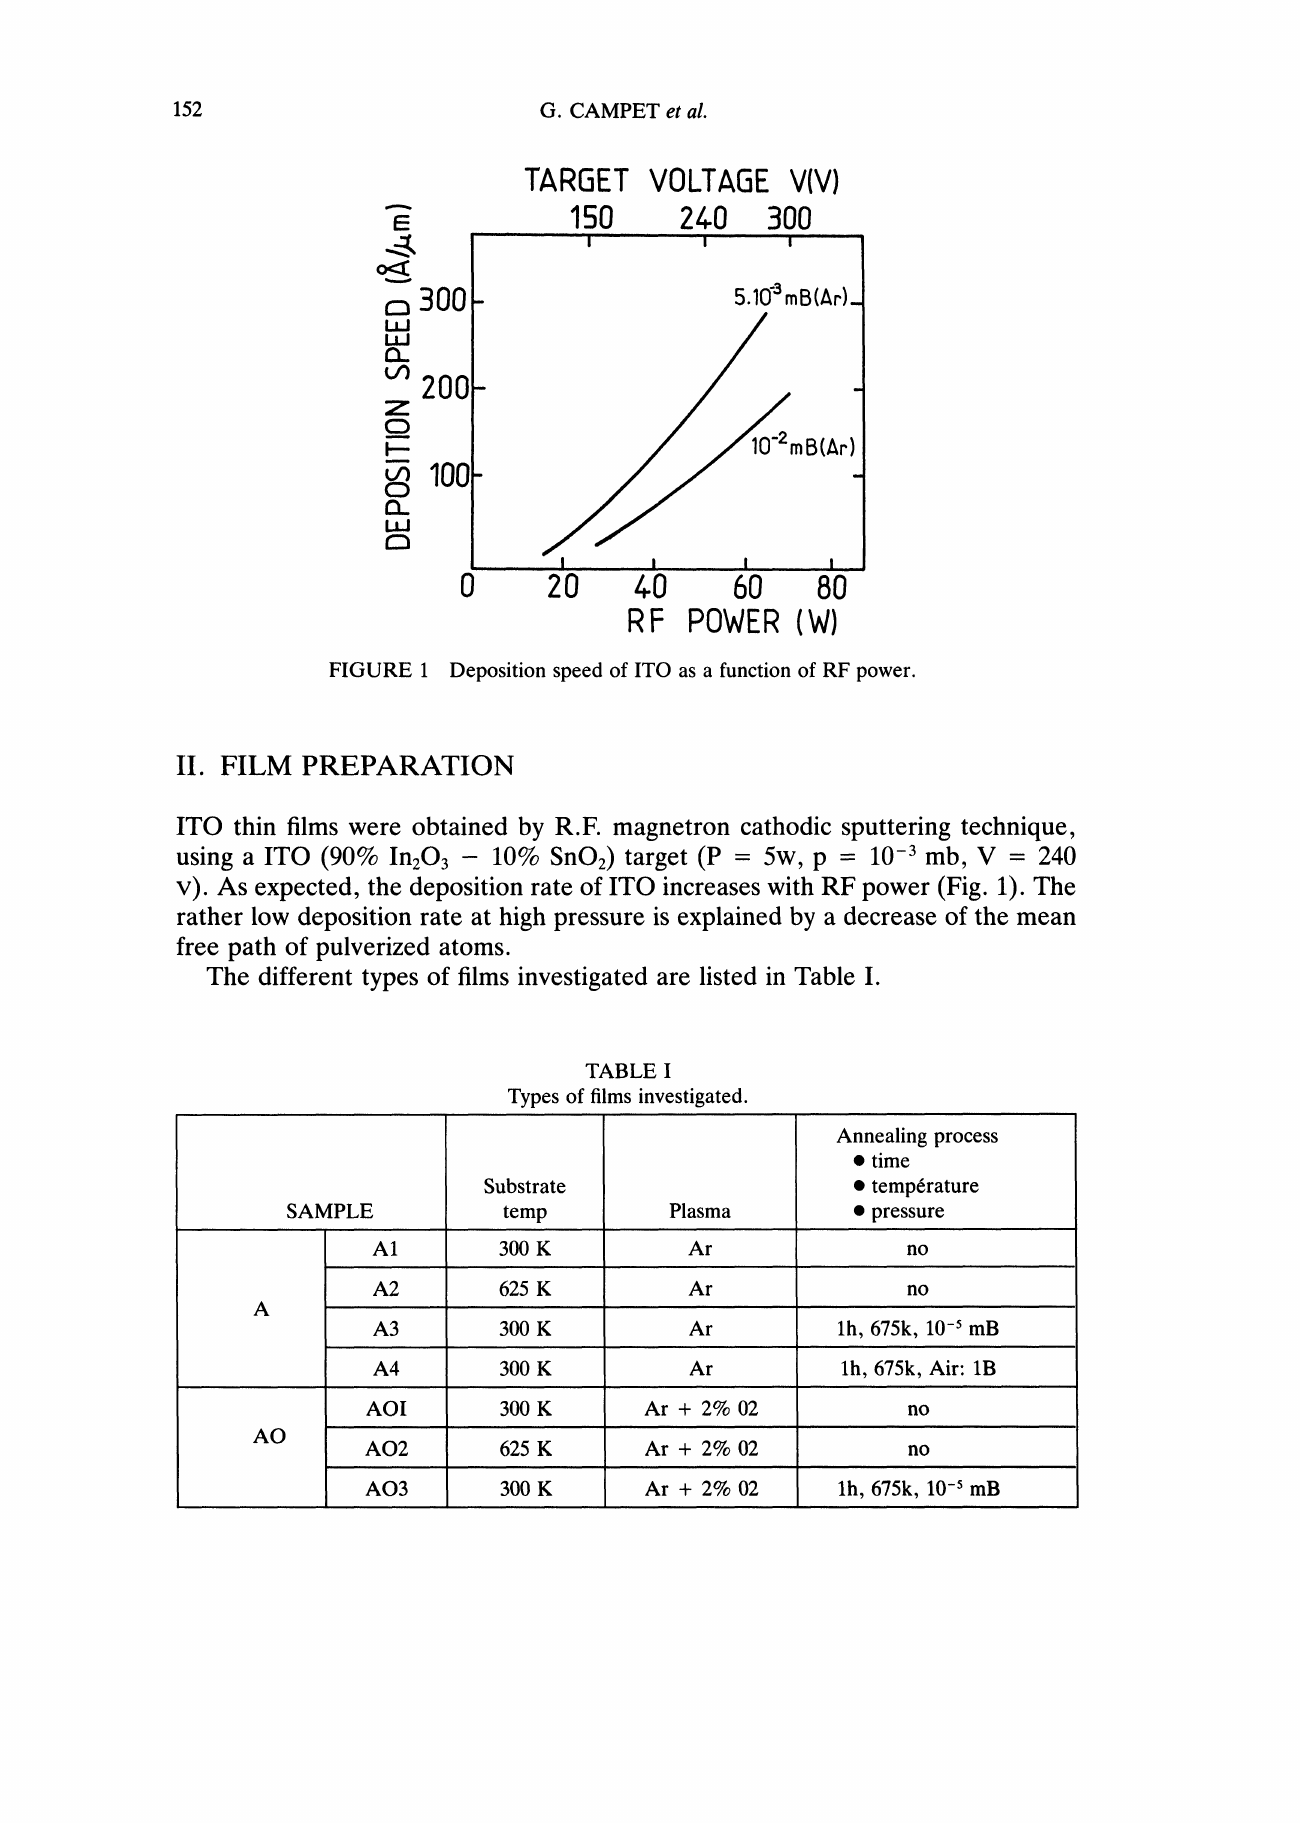
FIGURE Deposition speed of ITO as a function of RF power.